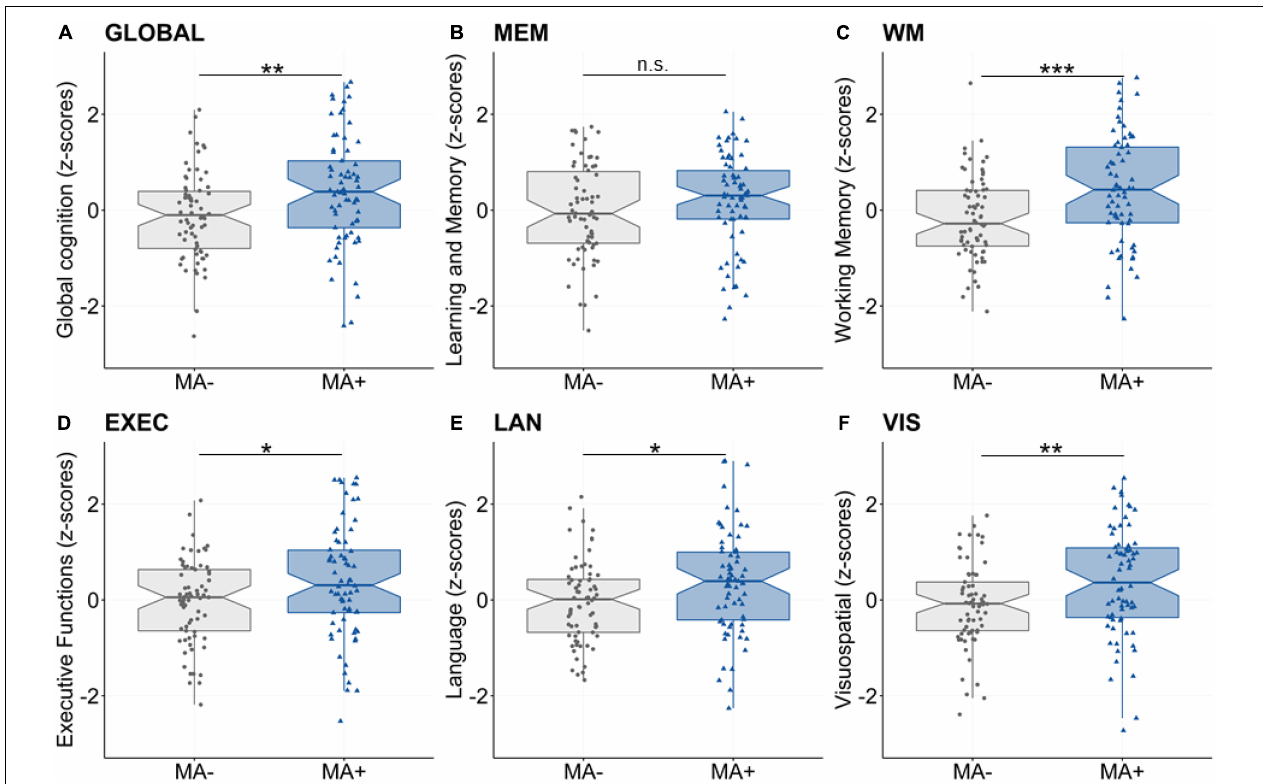
FIGURE 1 | Main effect of musical activity on multi-domain cognitive abilities. Significant group differences were found for global cognition ( A , GLOBAL), working memory ( C , WM), executive function ( D , EXEC), language ( E , LAN), and visuospatial abilities ( F , VIS). These multi-domain cognitive abilities were enhanced for participants with musical activity (MA+, blue) compared to controls (no musical activity across lifespan, MA-, gray). The association was not significant for the learning and memory composite ( B , MEM). Boxplots display unadjusted data with individual data points. The “notch” shows the median with 95% confidence intervals and interquartile range with lower (25th) and upper percentiles (75th). Significance levels (uncorrected): *** p < 0.001, ** p < 0.01, * p < 0.05. MA+, musical activity; MA–, no musical